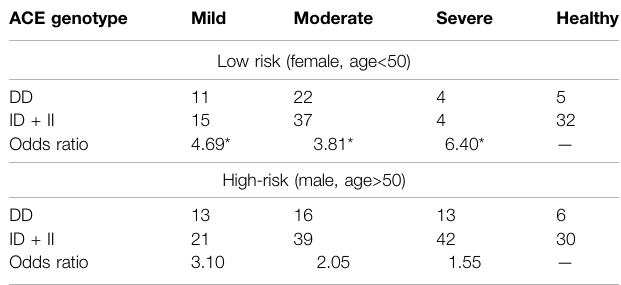
Statistical analysis of the association between COVID-19 and ACE polymorphism (multiple logistic regression analysis): ACE genotype (DD, more frequent in patients than incontrols);symptom(differentrelativefrequencyofpatientsinthethreesymptoms);and riskgroup(high-riskstatusmorefrequentincasesthanincontrols).HeterogeneityofACE and the genotype effect according to the risk group (DD genotype more strongly associated with COVID-19 in mild symptoms of the high-risk group and in severe symptoms of the low-risk group, * p value <